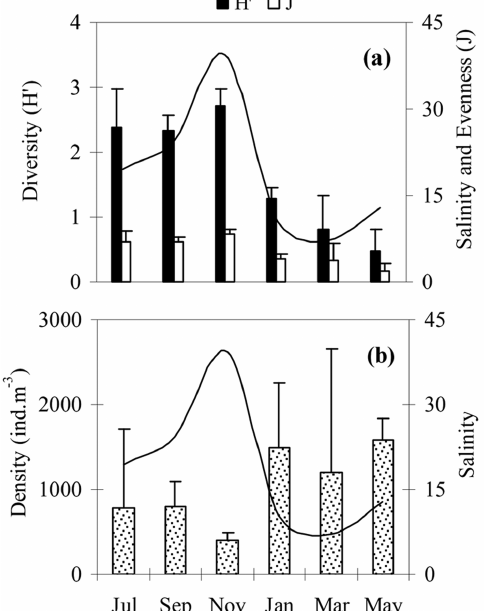
Fig. 3 – Monthly means ( ± SD) in copepod ecological indexes (a) and total copepod density (b) registered in the Curuçá estuary. These data were plotted against salinity